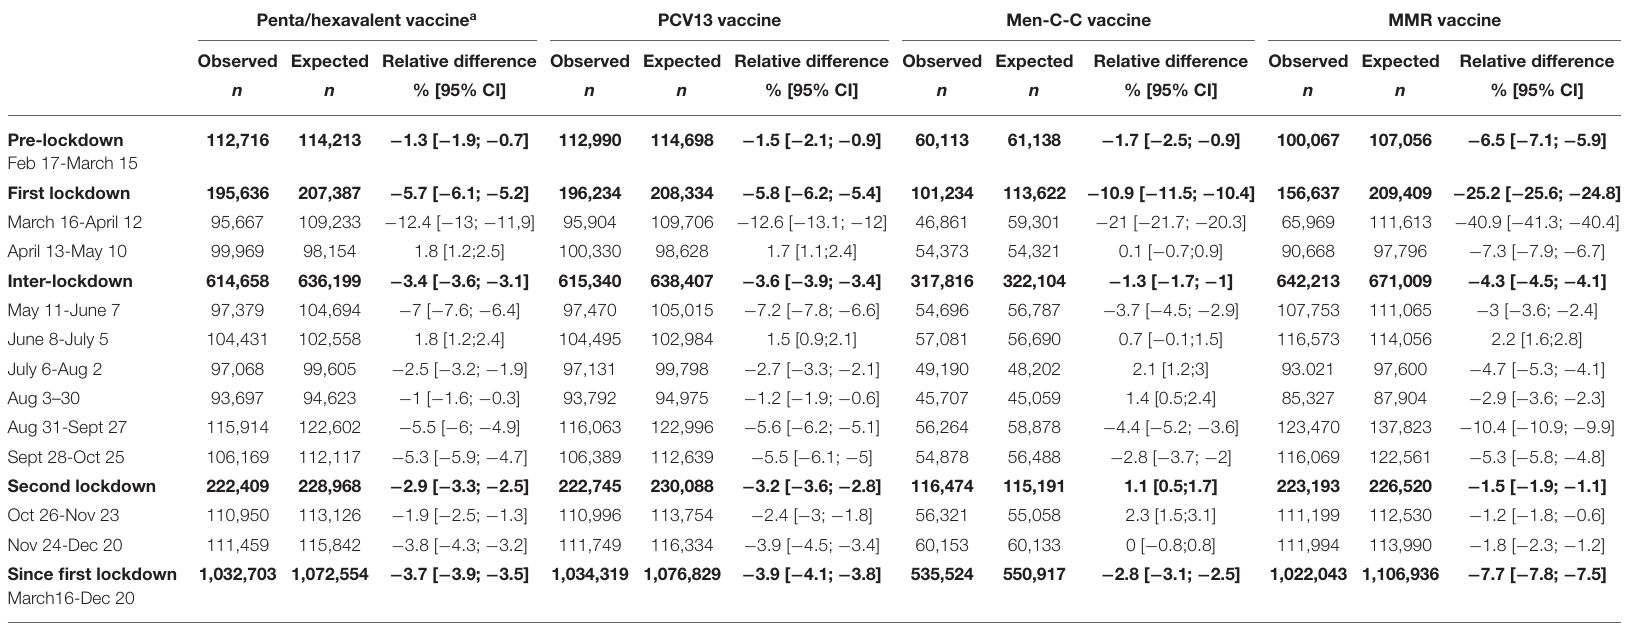
TABLE 1 | Relative differences between the observed and expected priming dose counts for penta/hexavalent, 13-valent pneumococcal conjugate (PCV13), meningococcal conjugate type C (Men-C-C), and measles mumps rubella (MMR) vaccines during the COVID-19 pandemic in France in 2020. Penta/hexavalent vaccine a PCV13 vaccine Men-C-C vaccine MMR